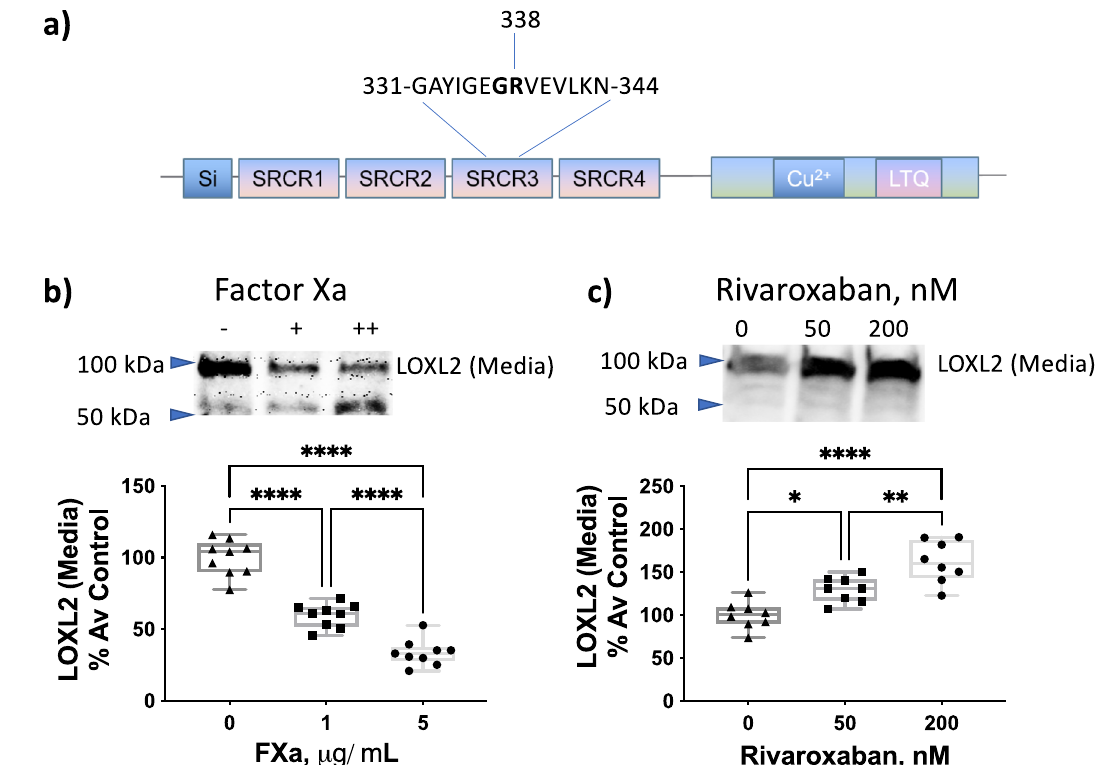
Fig. 1 FXa processes soluble LOXL2 in cell-culture media. a Predicted site for FXa processing of LOXL2. b Representative western blot and densitometry analysis in the conditioned media of A7r5 cells showing increased processing of LOXL2 when cells are treated with increasing levels of exogenous FXa (0, 1, or 5 μ g/ml) for 24 h ( n = 9; **** P < 0.0001 by one-way ANOVA) and c Representative western blot and densitometry analysis in the conditioned media of A7r5 cells with inhibition of endogenous FXa using the FXa-speci fi c inhibitor, rivaroxaban (0, 50, 200 nM) for 24 h shows the accumulation of the full- length LOXL2. ( n = 8; mean ± SEM; * P < 0.05, ** P < 0.01, **** P < 0.0001 by one-way ANOVA).